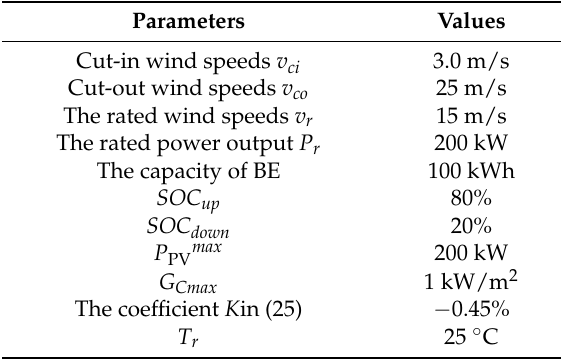
Table A1. Parameters of DERs’ outputs